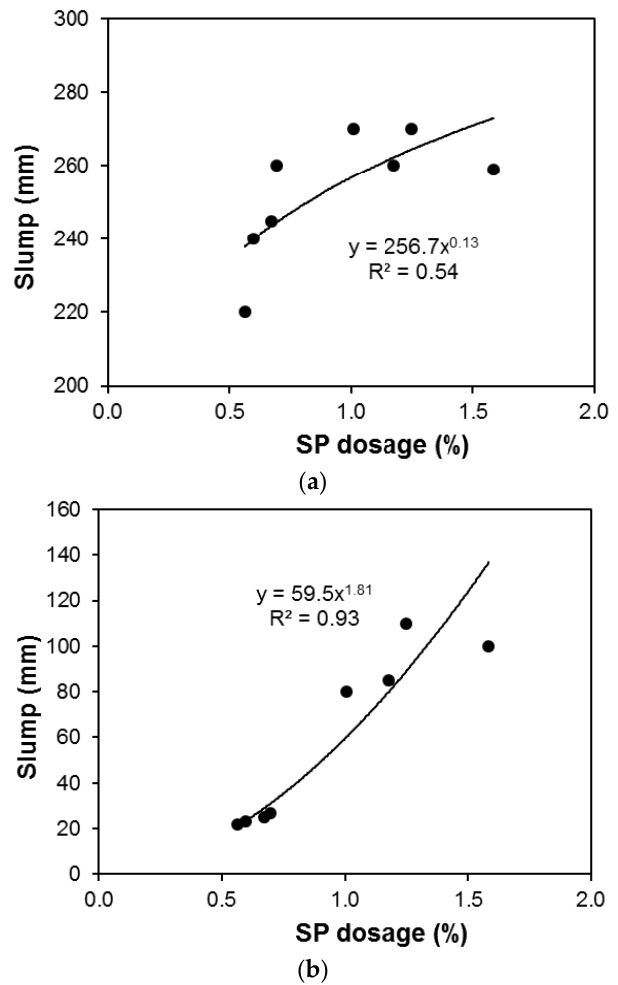
Figure 6. Influence of SP dosage on slump of concrete ( a ) without fibers; ( b ) with fibers.